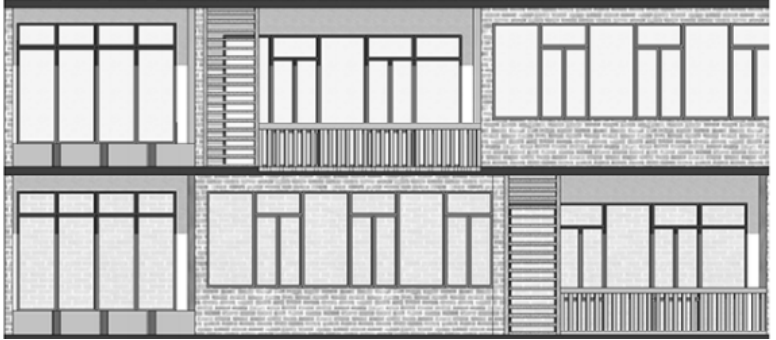
Fig. 3 Grid elevation diagram of the